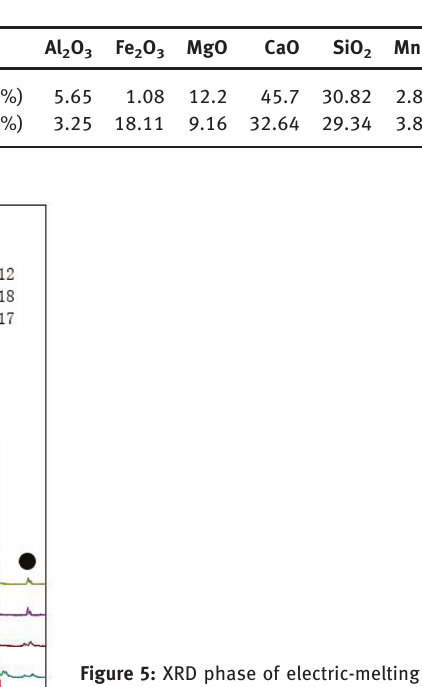
Figure 5: XRD phase of electric-melting